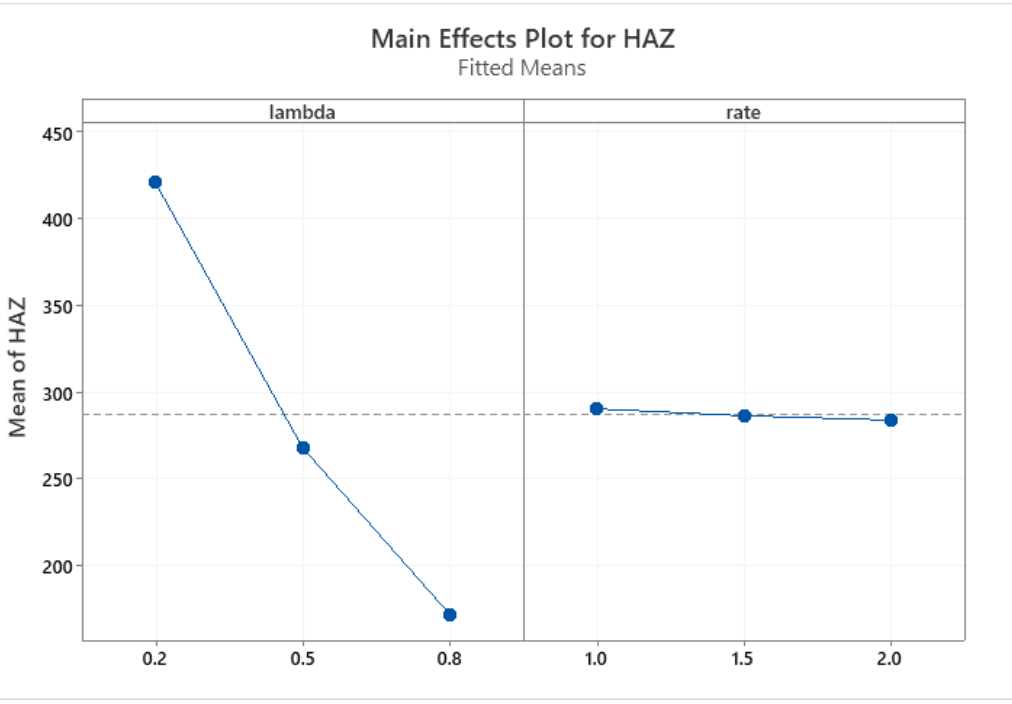
Figure 18. Marginal means plot for HAZ hardness with respect to the lambda (share of AISI316L) and rate (speed of alloying) explanatory variables.